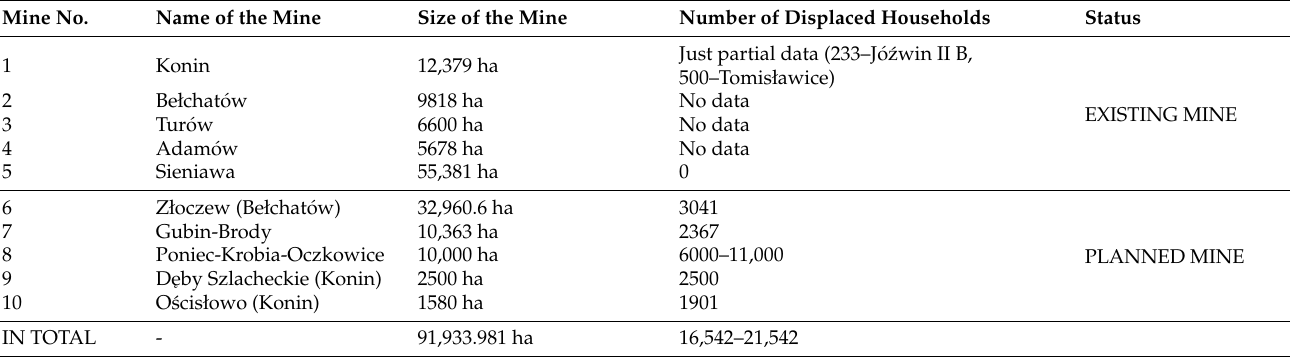
Table 3. Basic data on lignite deposits in Poland.